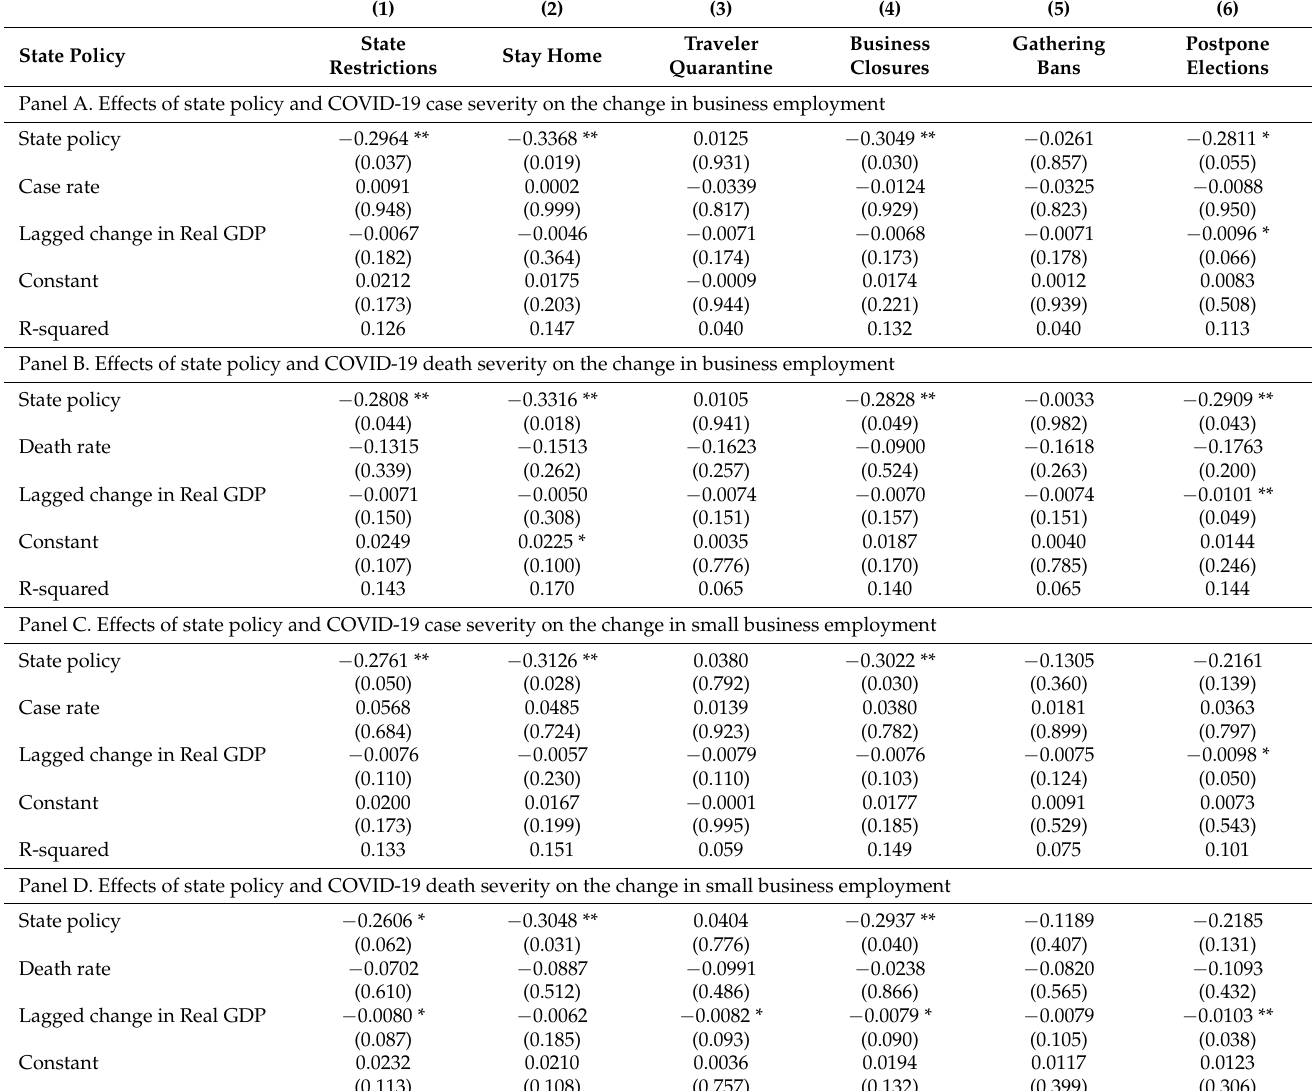
Table 9. Effects of state policies and COVID-19 severity on local business